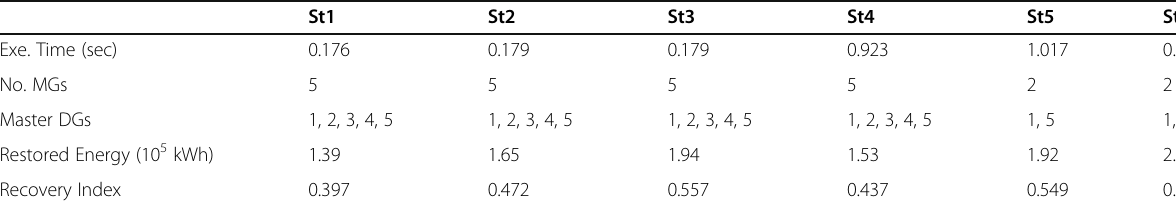
Table 2 Impact of applying different strategies